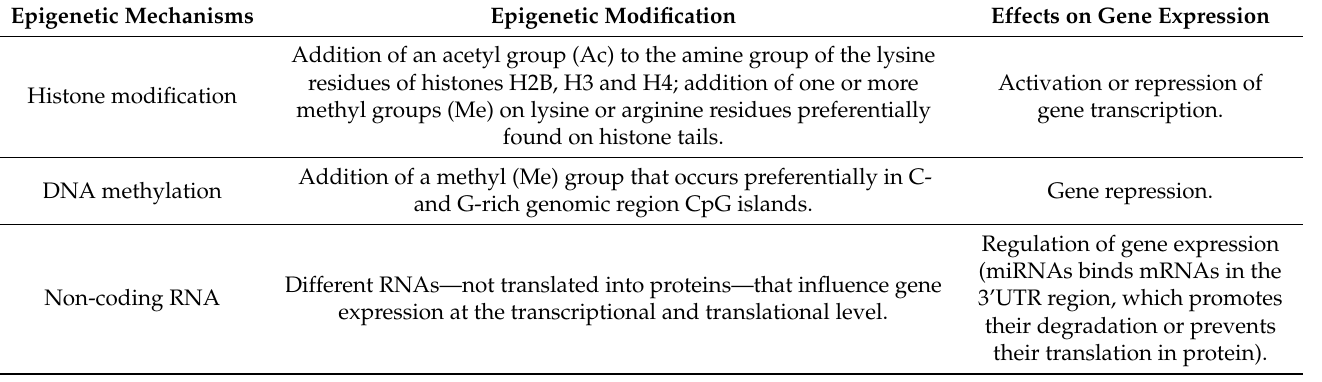
Table 1. Summary of all epigenetic changes.